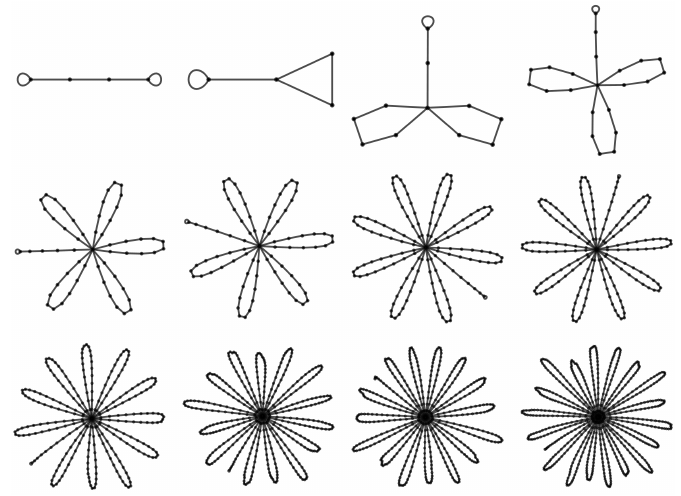
Figure 16. A p for p the squares of first 12 primes. The descriptor language for these types of graphs − 1 would be that they are q -petal 2